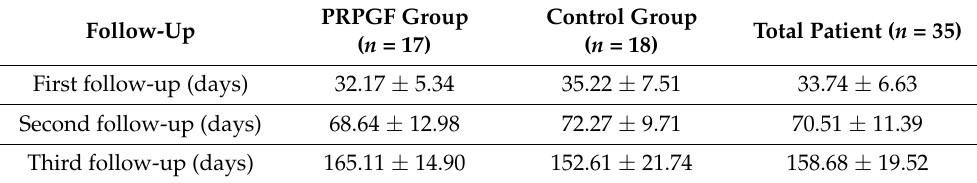
Table 2. Days follow-up mean for